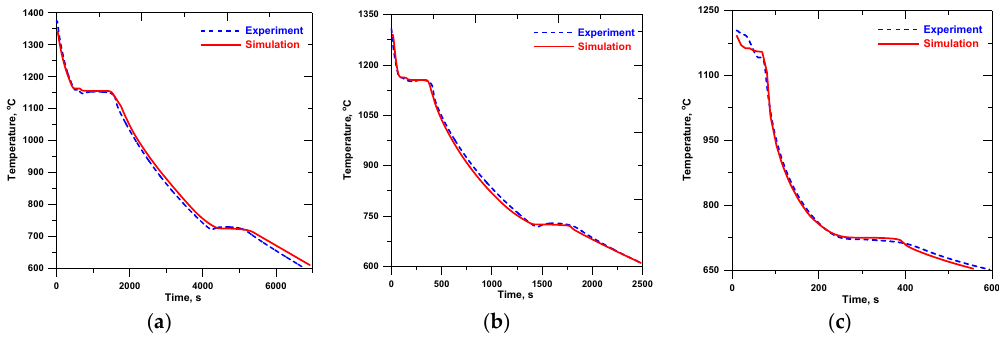
Figure 6. Simulated and experimental cooling curves (central thermocouple) for alloy A: ( a ) insulation, ( b ) sand, and ( c ) chill.